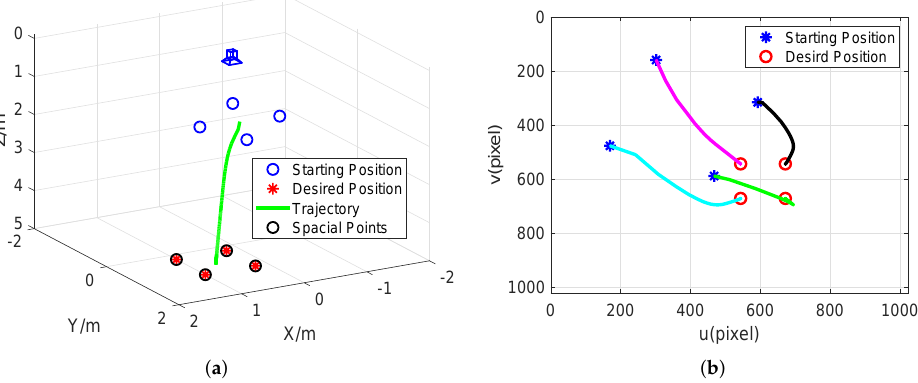
Figure 7. Simulation results by the classical controller: ( a ) Complete Spatial trajectory of the robotic arm. ( b ) Image